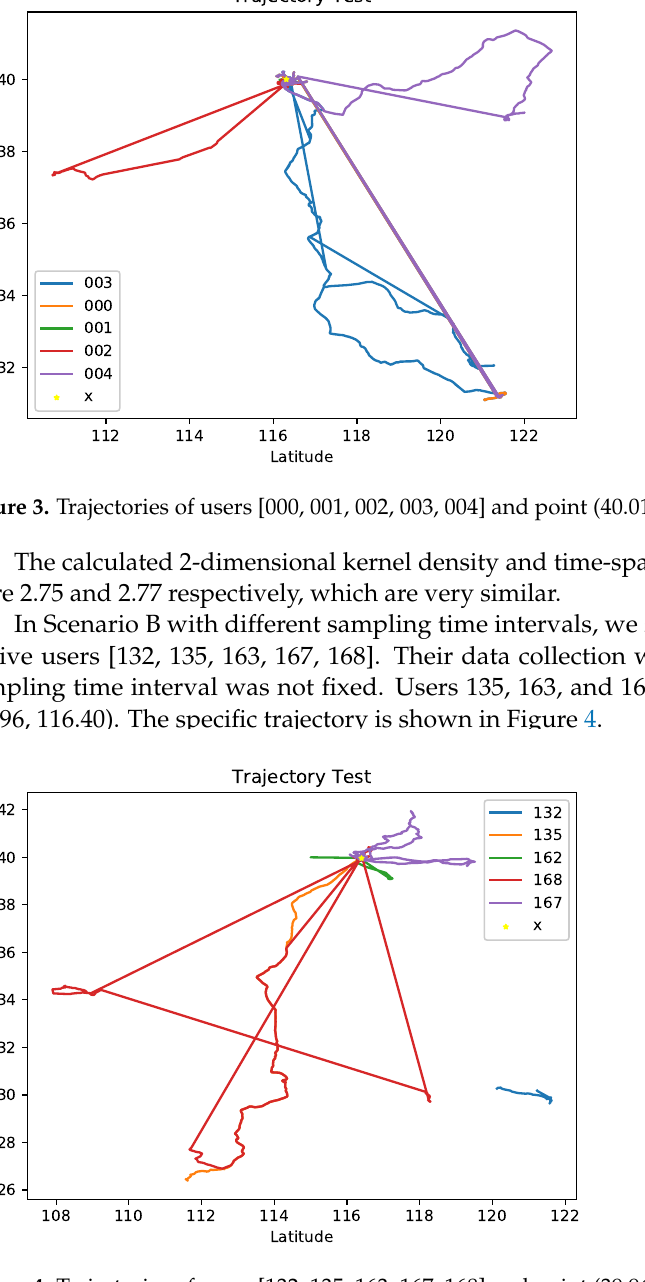
Figure 4. Trajectories of users [132, 135, 163, 167, 168] and point (39.96,